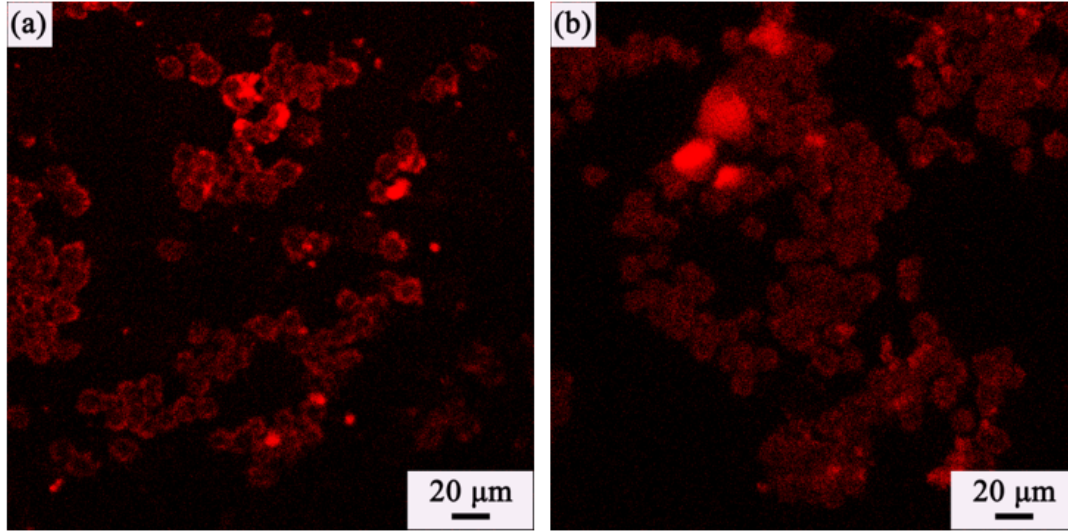
Figure 6. LSCM (Laser Scanning Confocal Microscope) images of macrophages after being cultured with ( a ) NH 2 -NaYF 4 :Eu 3 + and ( b ) NH 2 -NaYF 4 :Tb 3 + . The display color is a fake color automatically assigned by the test system.